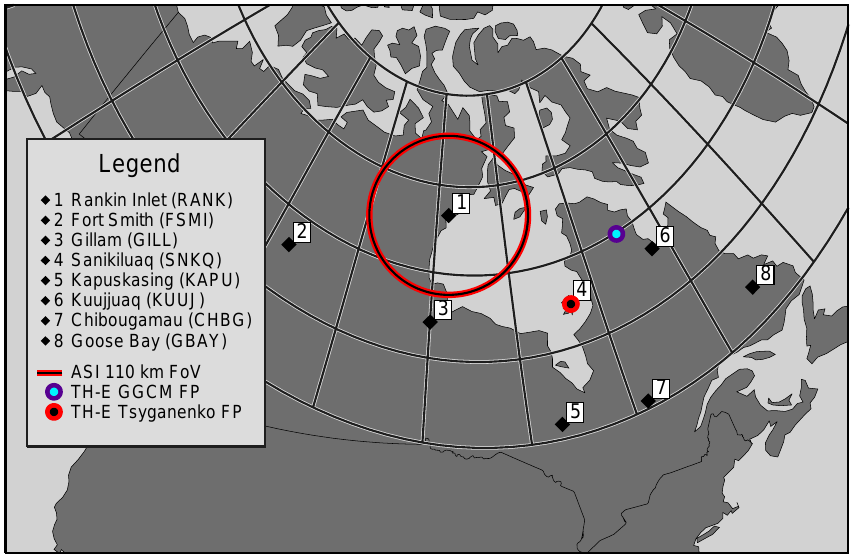
Fig. 9. Themis E footpoint obtained using the OpenGGCM MHD model (blue and purple dot) and the Tsyganenko T96 model (black and red dot), together with the locations of some ground stations. The red and black circle marks the Rankin Inlet field-of-view at 110km